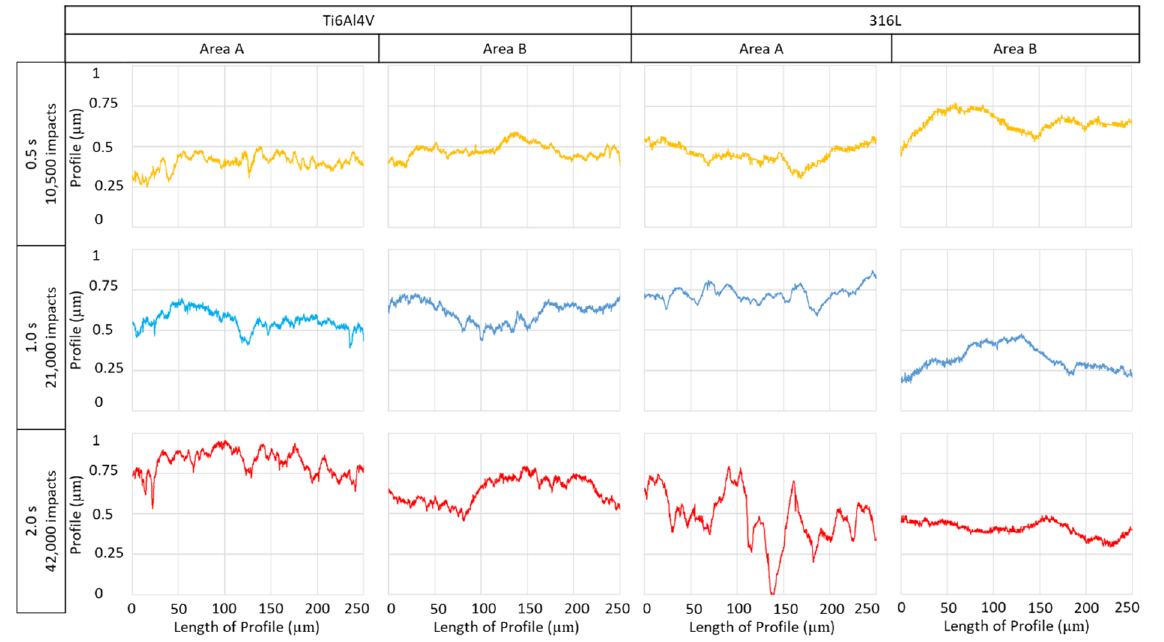
Figure 6. Results of confocal microscopy of Ti6Al4V and 316L samples treated by 42,000 impacts from a pulsing water jet (PWJ), supported by a graph comparing the profiles of the different number of impacts for areas A and